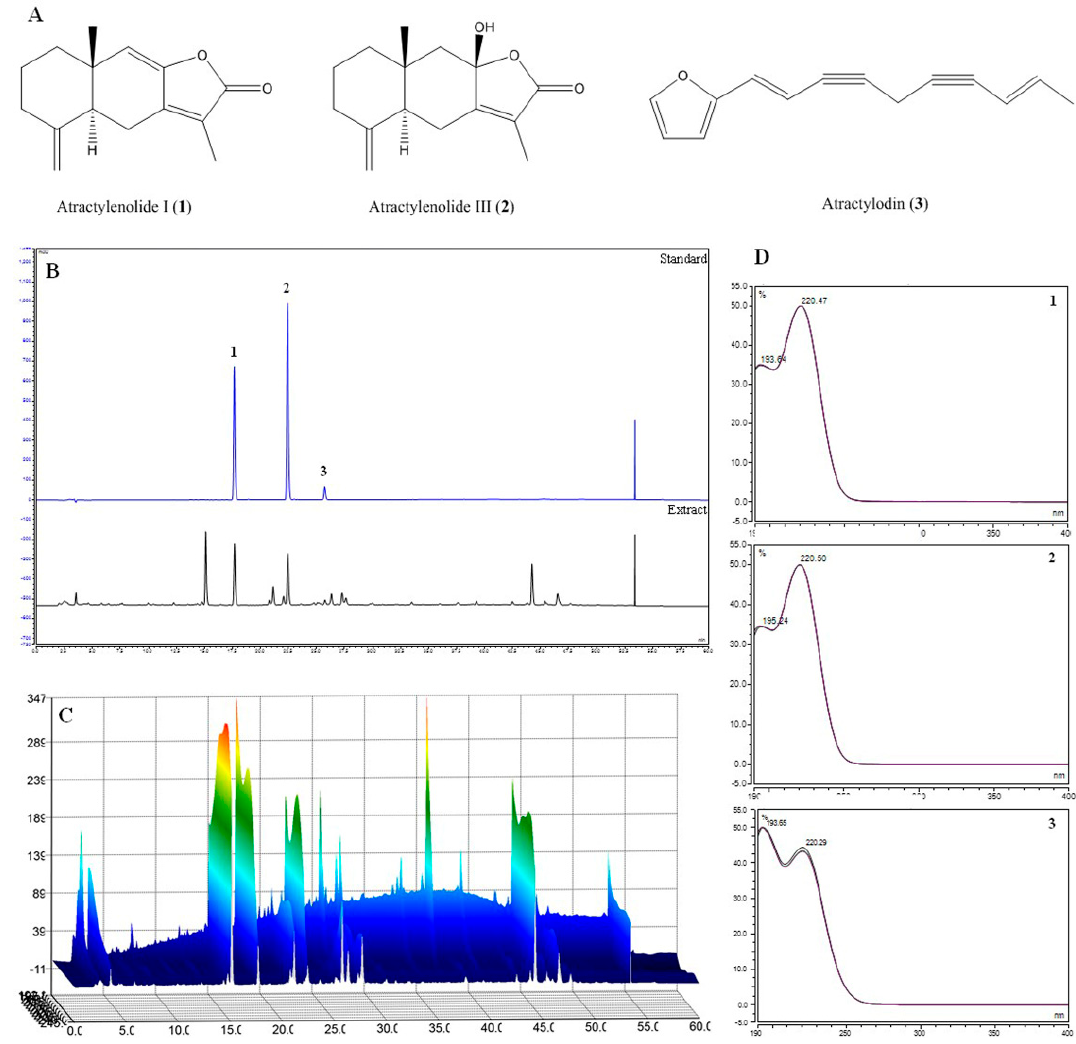
Figure 5. Structure of three major compounds ( A ), high-performance liquid chromatography